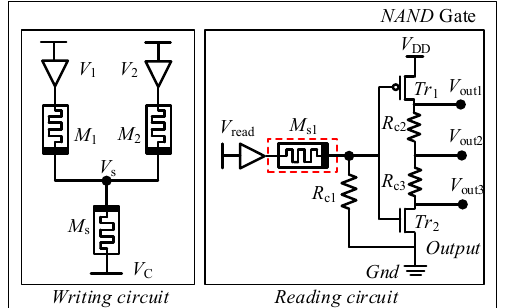
Figure 4. The circuit diagram for the implementation of a NAND gate (including writing circuit and reading circuit).